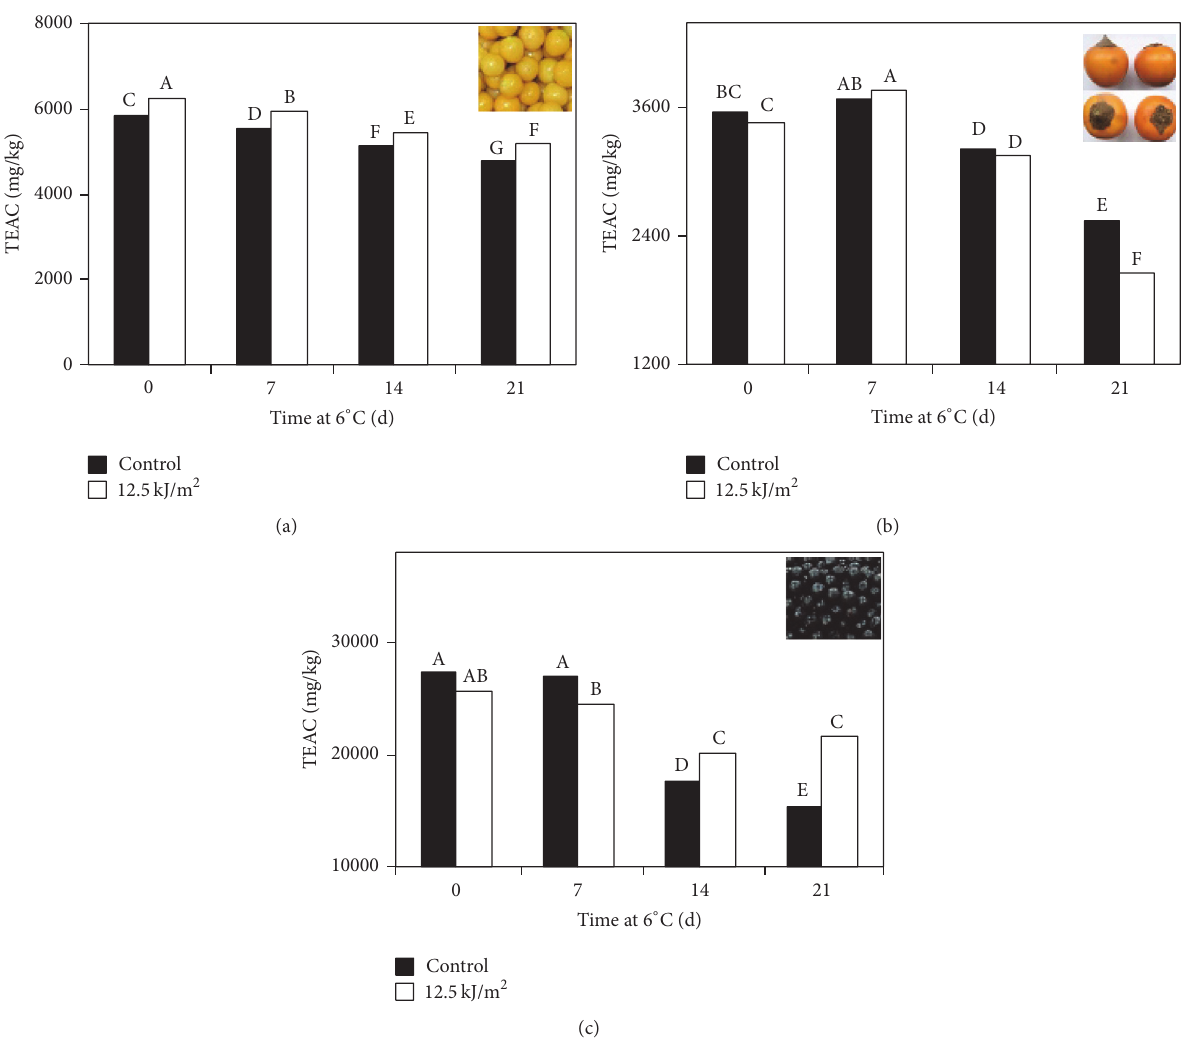
Figure 2: Antioxidant capacity (TEAC, Trolox Equivalent Antioxidant Capacity) in control and UV-C treated (12.5 kJm −2 ) uvilla (a), naranjilla (b), and morti˜no (c), stored at 6 ∘ C for 0, 7, 14, or 21d. For each fruit, different letters between treatments show differences according to a Fisher test ( 𝑃 < 0.05